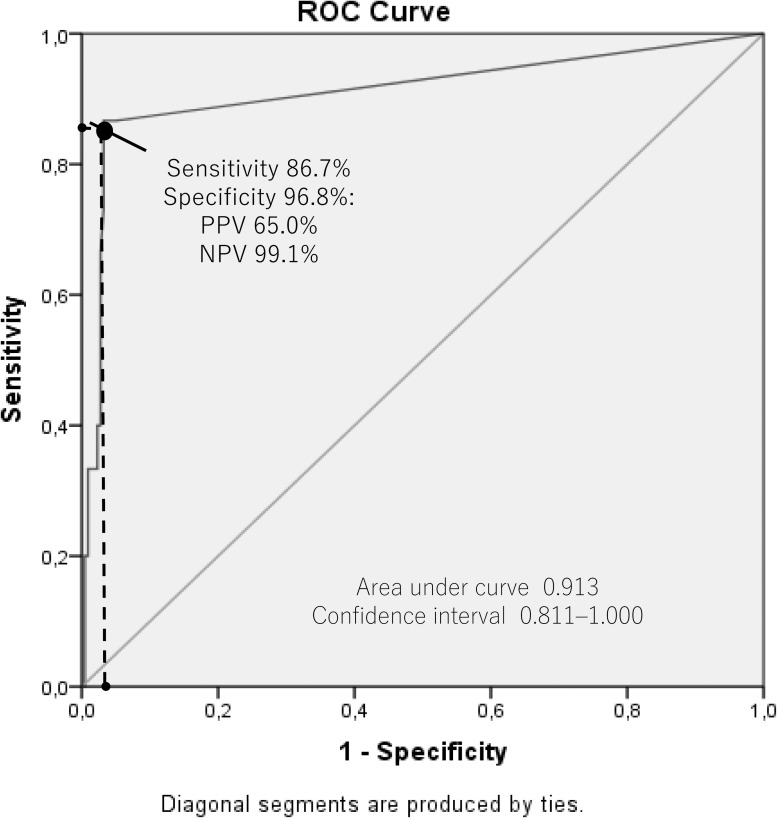
Receiver-operating characteristic (ROC) curve for determining the optimal cutoff of Helicobacter pylori antibody titers.The sensitivity delineated in X-axis (86.7%) and the Y-axis characterized value of 1-specificity (96.8%). PPV was a positive predictive value and NPV was a negative predictive value.